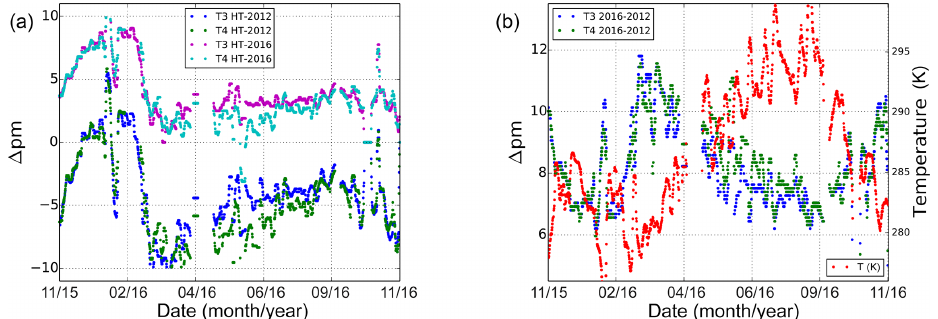
Figure 7. Four-day median post-processed GreenLITE ™ offsets in wavelength from measured or nominally tuned values required to compute column CO 2 values given in Fig. 6. The median values were computed every 6h over a 4d window for all chords and each transceiver–RT- model combination. Panel (a) illustrates the median wavelength offset values, and panel (b) shows the differences between the T3 and T4 values along with median air temperature for the same period. The blue and green data represent the wavelength offset for the data reprocessed using LBLRTM 12.8 and line parameters based on HITRAN 2012 (HT-2012), and the cyan and magenta data represent those generated with a combination of LBLRTM 12.8 and line parameters derived from HITRAN 2016